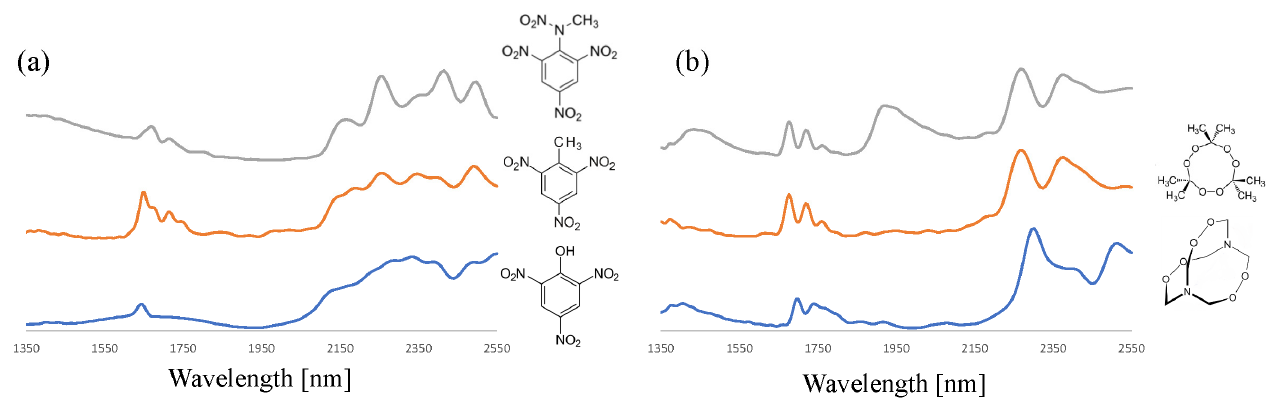
Figure 5. SNV-corrected, average NIR spectra (n = 5) of ( a ) tetryl, TNT, and picric acid (grey, orange, and blue trace, respectively) and ( b ) TATP (wet), TATP (dry), and HMTD (grey, orange, and blue trace, respectively). The o ff set has been adjusted to facilitate spectrum comparison.